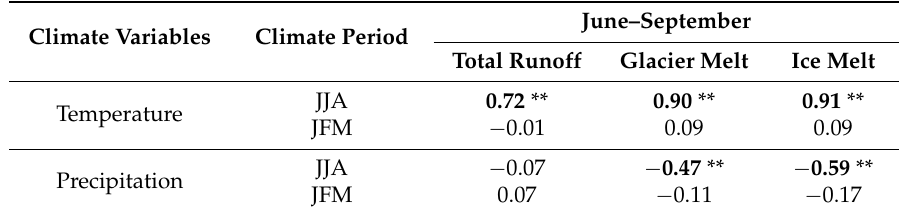
Table 3. Seasonal correlation between total runoff, glacier melt and ice melt and temperature and precipitation in the Yarkant River basin from 1968 to